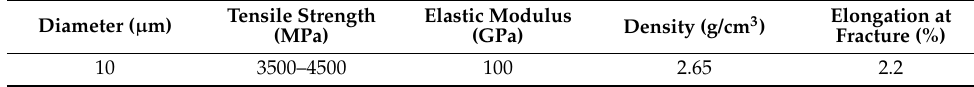
Table 2. Physical and mechanical properties of basalt fiber [34].